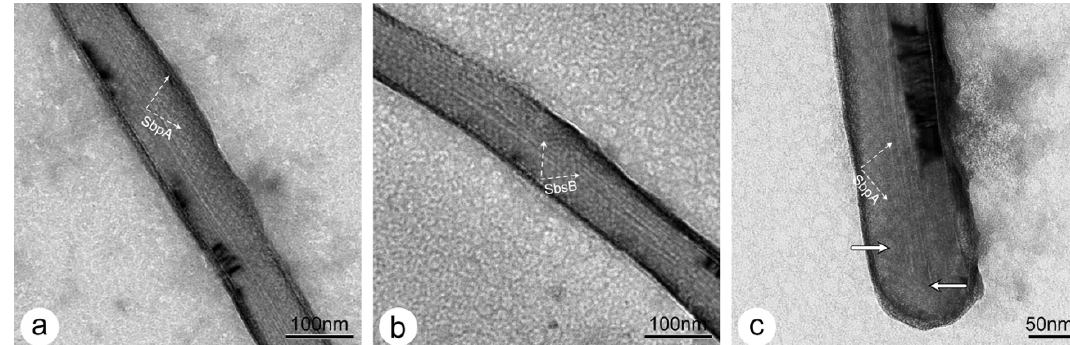
Figure 2. TEM images of negatively stained ( a ) SbpA- and ( b ) SbsB-coated pristine MWNTs. The end of a MWNT closed with a SbpA cap is shown in ( c ). The S-layer lattice shows a good long-range order in the cylindrical part, while lattice defects can be seen close to or on the cap, which is a requirement for the protein lattice to cover the curved surface (marked by arrows).